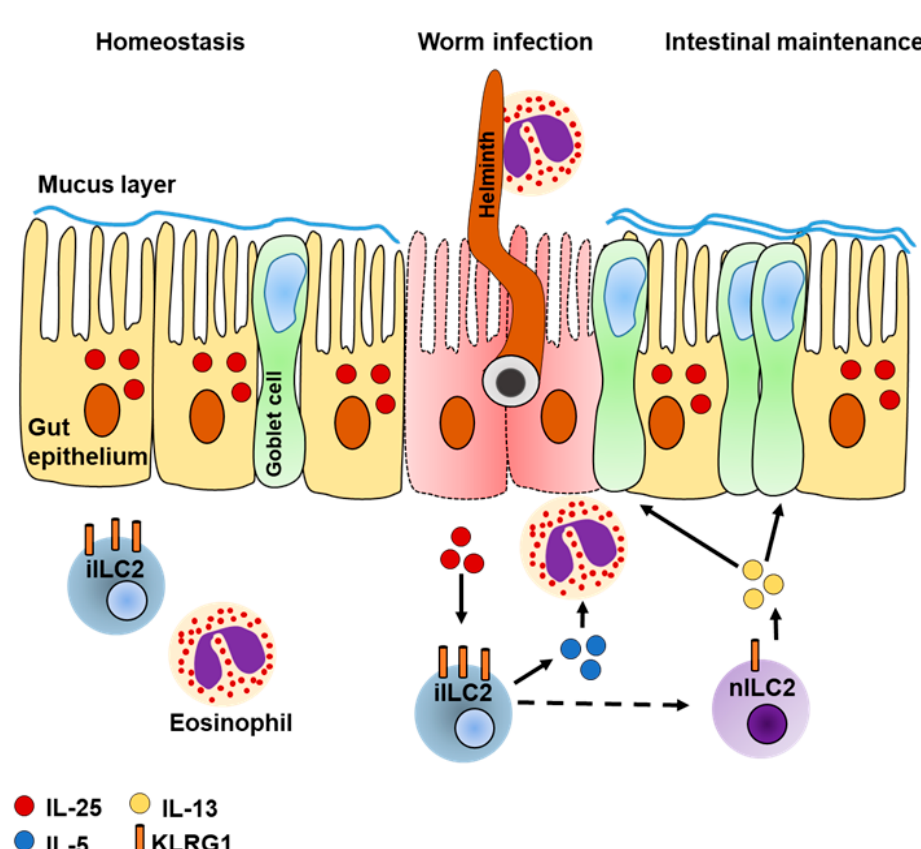
Figure 2. Suggested model of anti ‐ helminth immunity by intestinal inflammatory ILC2s (iILC2s). KLRG1 hi iILC2s express IL ‐ 5 in response to IL ‐ 25 ‐ dependent activation to recruit eosinophils that amplify worm expulsion. In parallel, iILC2s convert into natural ILC2s (nILC2s) (indicated by dashed arrow) that downregulate KLRG1 and express IL ‐ 13 thereby promoting goblet cell hyperplasia and increased mucus production to restore the function of the intestinal epithelium. Solid arrows indicate the release and effect of the respective stimulus.